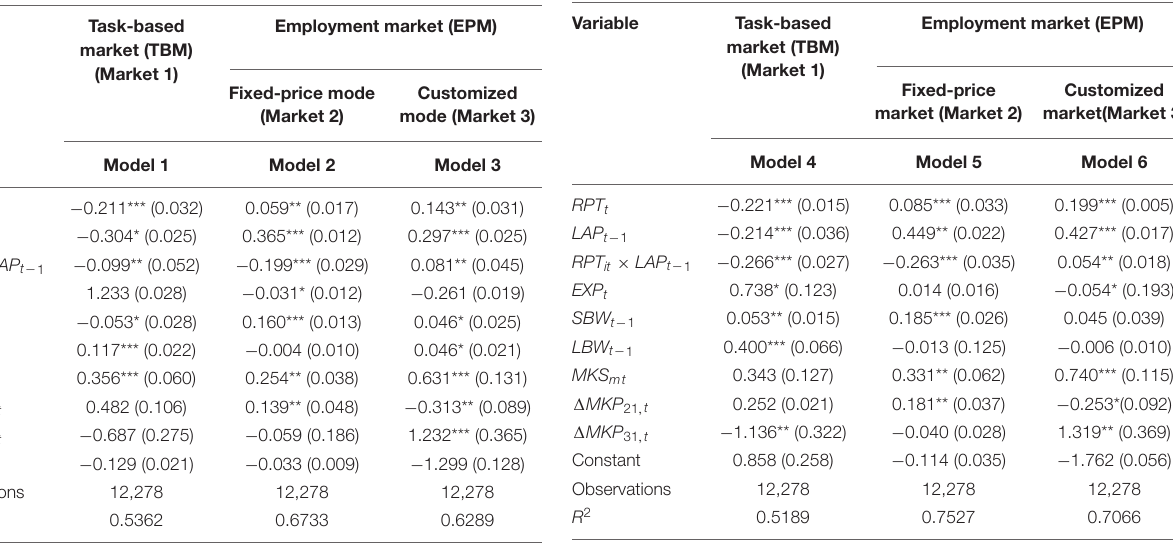
TABLE 5 | Panel fixed-effects regression analysis results of vendors’ market revenue